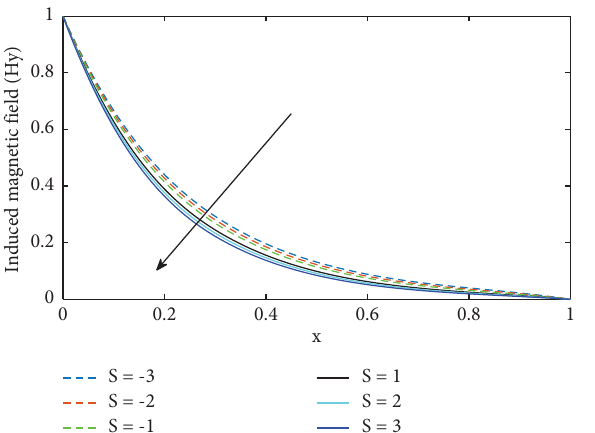
Figure 14: Induced magnetic feld profles for diferent values of S .